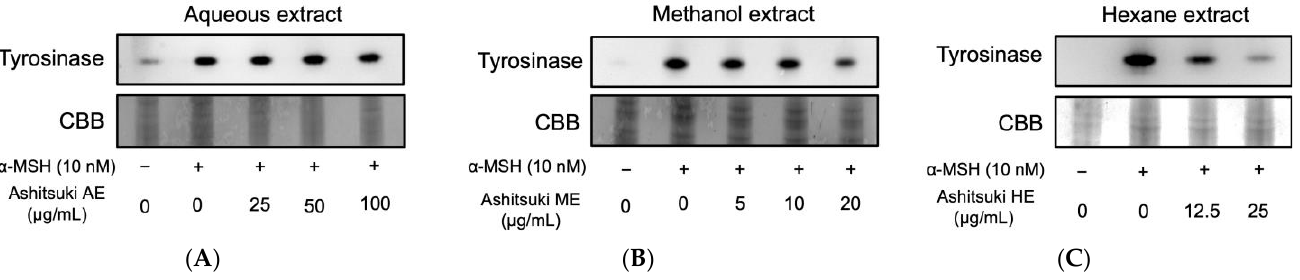
Figure 8. Effect of N. verrucosum ( ashitsuki ) hexane extract on tyrosinase and Mitf protein levels. B16F1 melanoma cells were treated with N. verrucosum hexane extract for 72 h in the presence of 10 nM α -MSH. After treatment, total cell lysates were prepared, and western blot analysis was per- formed. 3.6. Influence of N. verrucosum HE on Melanogenic Genes Transcription Real-time RT-PCR analysis was performed to elucidate the effect of N. verrucosum on melanogenic gene transcription. Figure 9A shows the mRNA levels of genes in B16F1 mel- anoma cells after 72 h of treatment with the HE. In the absence of α -MSH, the tyrosinase mRNA level was slightly increased after N. verrucosum extract treatment. In contrast, the MC1R mRNA level was significantly decreased after treatment (approximately 40% of the untreated control). In the presence of α - MSH, the HE suppressed the α -MSH-induced in- crease in tyrosinase mRNA level. The TRP-1 and TRP-2 mRNA levels were suppressed by treatment with N. verrucosum extract at 6.25 and 12.5 µg/mL. The MC1R mRNA level was decreased in cells treated with α -MSH alone compared with that in the non-treated con- trol. The MC1R mRNA levels in N. verrucosum extract and α -MSH co-treated cells were reduced (approximately 24% at 6.25 µg/mL and 30% at 12.5 µg/mL of the α -MSH-alone- treated control). Unexpectedly, the Mitf mRNA level did not show a significant difference after 3 d of treatment. The transcription levels of genes in the cells treated with N. verru- cosum extract for 24 h were also assessed (Figure 9B); the tyrosinase and MC1R mRNA